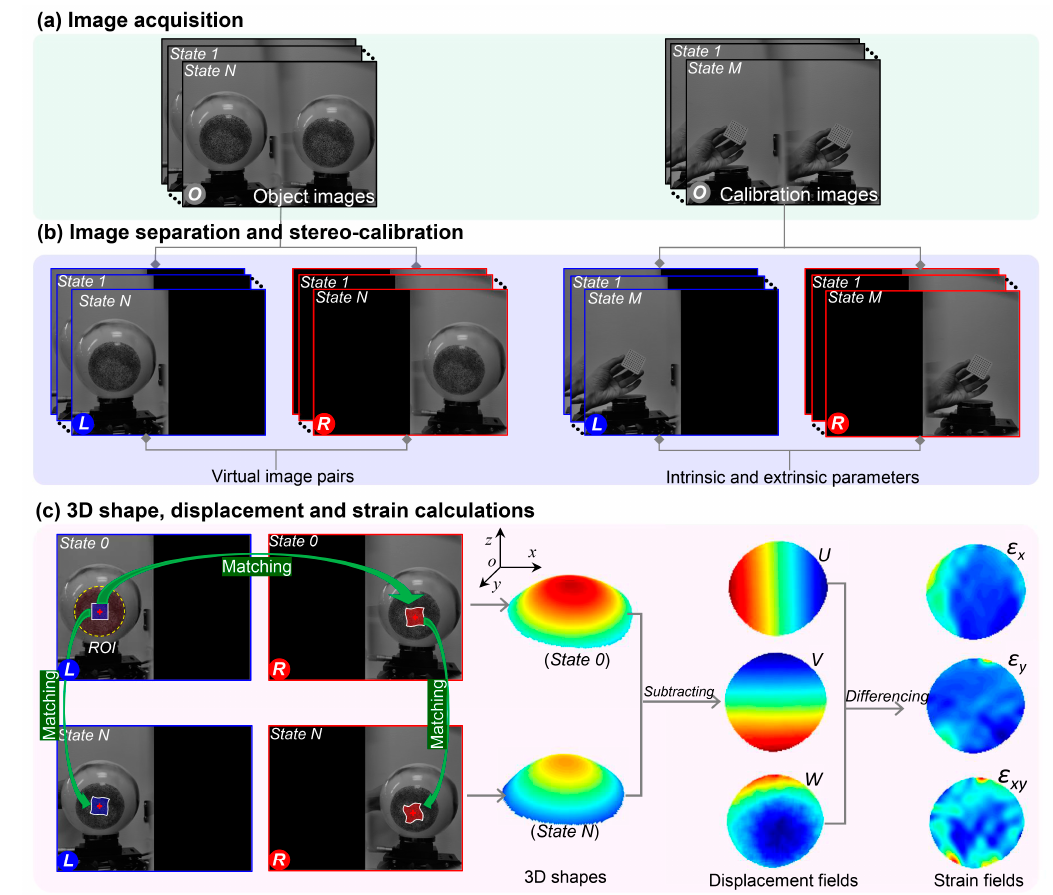
Figure 2. Schematic showing the procedures for measuring the 3D shape, displacement and deformation on the object surface: ( a ) image acquisition process, ( b ) image separation and the stereo-calibration process, and ( c ) the 3D shape, displacement and deformation calculation process. The letters O , L and R in the images represent the original image, virtual left image and virtual right sub-images, respectively. State N and state M mean the object and calibration images recorded in a certain state.